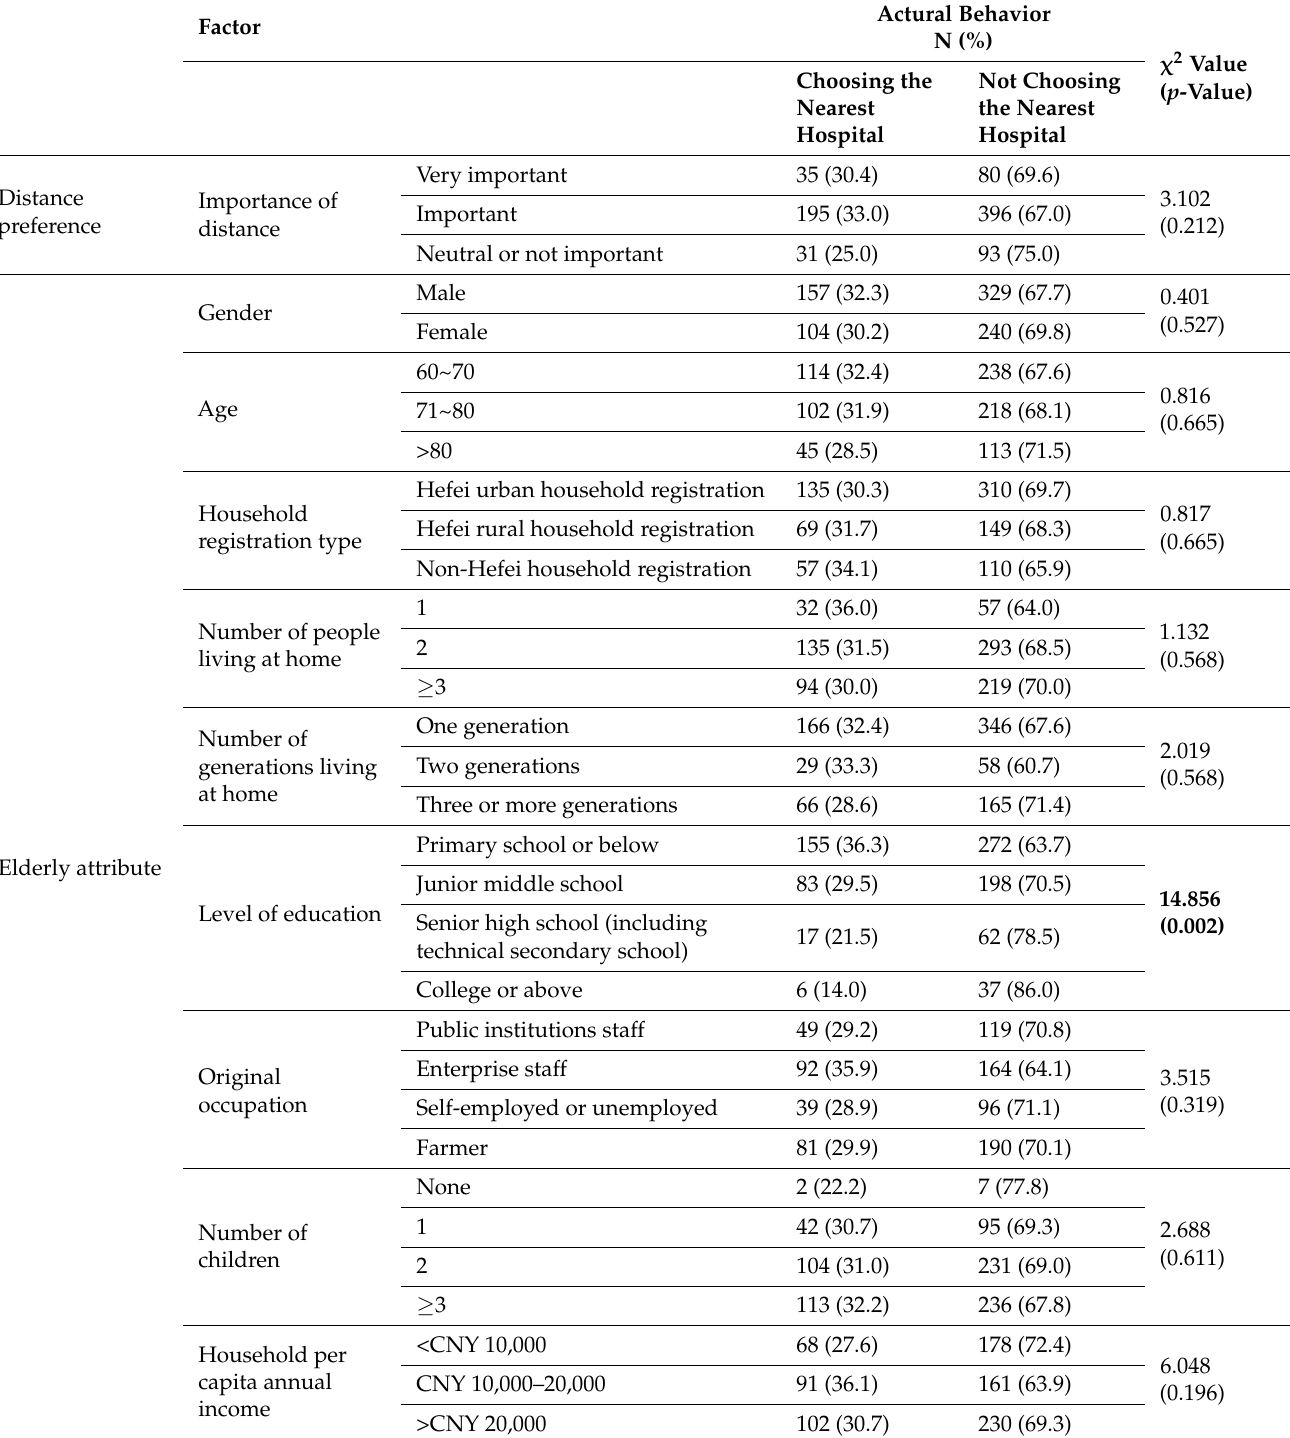
Table 5. Chi-squared analysis of the elderly’s preference, attributes, and actual